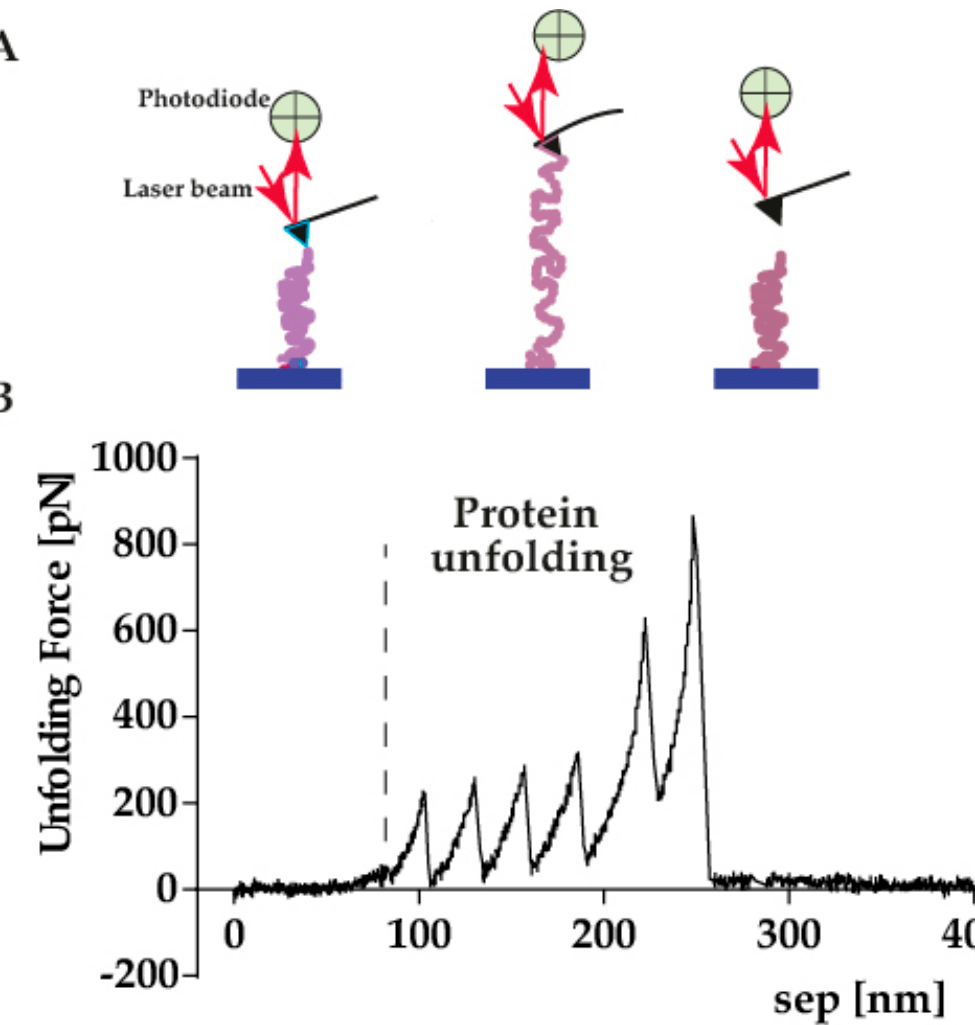
Figure 1. ( A ) Schematic representation of the AFM single molecule force spectroscopy experiment during unfolding of a protein. The AFM cantilever is lowered, and the pulling force is recorded during unfolding of the studied protein. ( B ) Force-extension curve showing a detailed spectrum of force peaks. Each force peak denotes an interaction that has been established by an unfolding intermediate. Fitting each force peak using the worm-like-chain (WLC) model reveals the contour length of the unfolded and stretched protein.